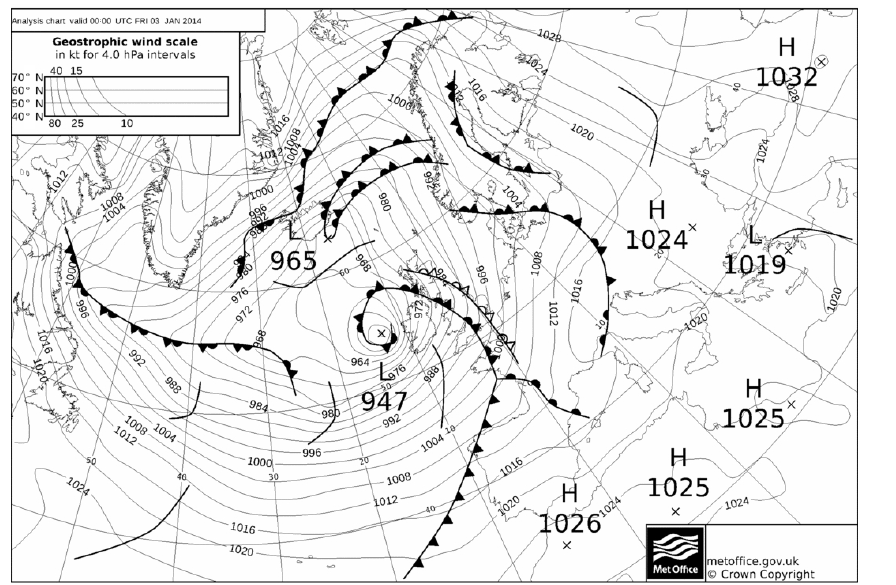
Figure 8. Synoptic chart of storm “Christina” on 3 January 2014 at 00:00UTC. © Crown Copyright (Met Office, UK).